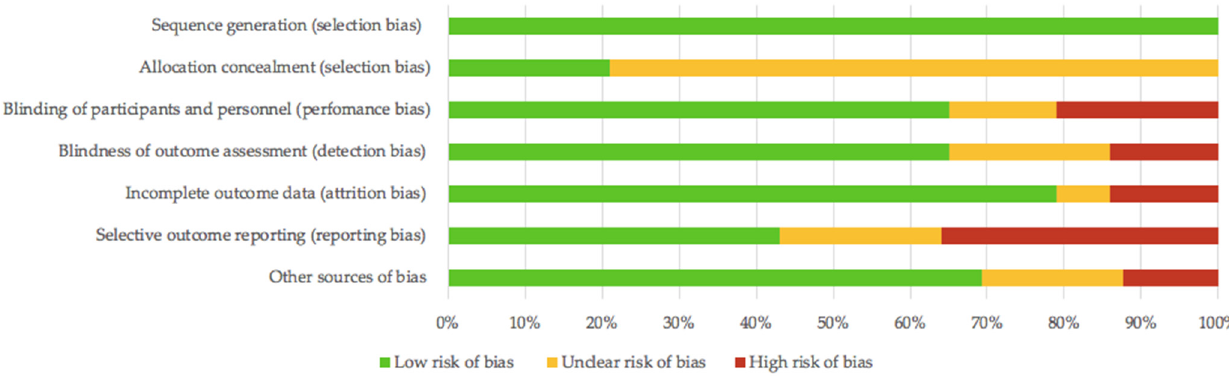
Figure 2. Risk of bias summary.